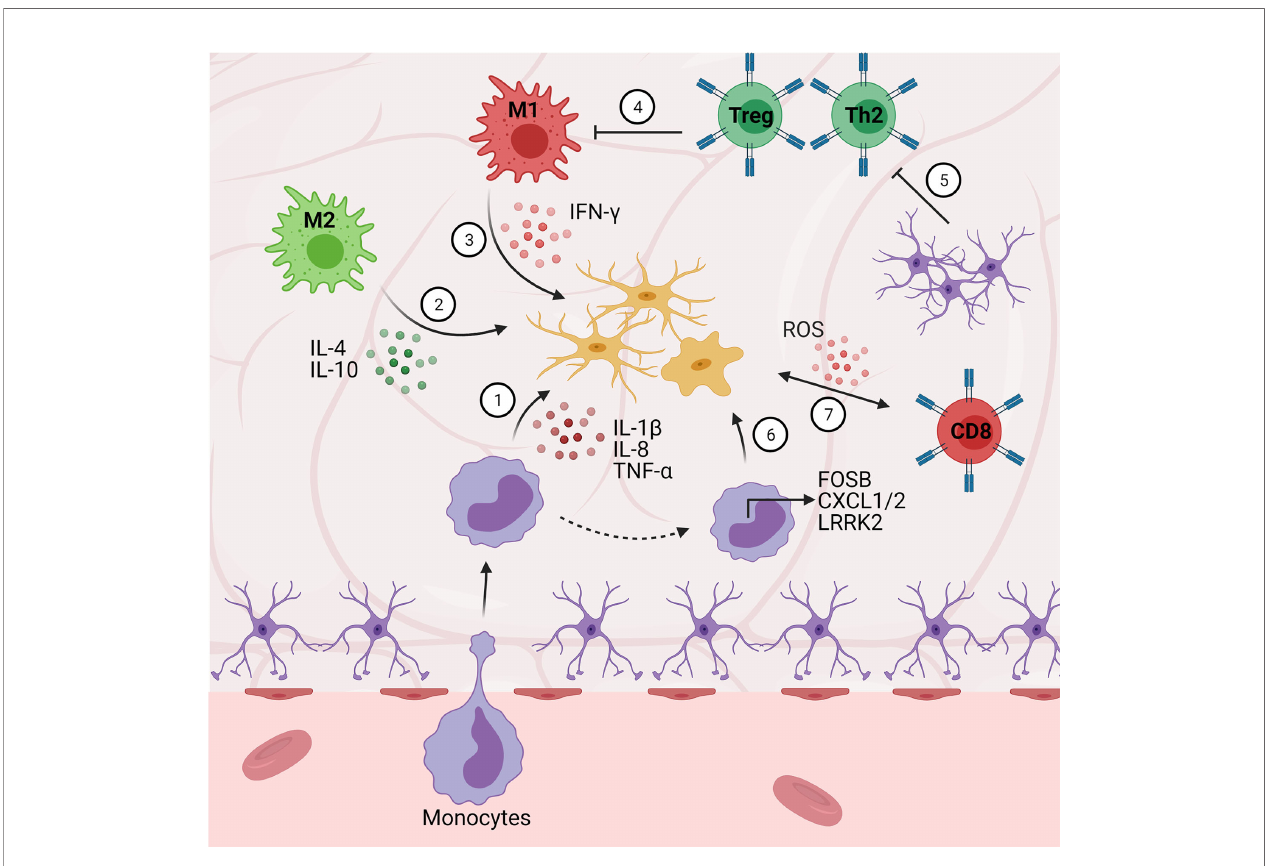
FIGURE 3 | Central-peripheral immune crosstalk in neurodegenerative diseases. (1) In fi ltrating monocytes secrete pro-in fl ammatory factors that activate microglia (e.g., IL-1B, IL-8, FOSB, CXCL1/2). (2) M2 macrophages play an early neuroprotective role via anti-in fl ammatory cytokine (e.g., IL-4, IL-10) secretion. (3) Alternatively, M1 macrophages play a late neurotoxic role via secretion of pro-in fl ammatory cytokines (i.e., IFN- g ). (4) Peripheral Th2 cells downregulate pro-in fl ammatory cytokine secretion (e.g., GM-CSF, TNF- a , IL-2) resulting in decreased microgliosis. (5) Astrocytes secrete TGF- b 1, suppressing neuroprotective T cell responses (ultimately disinhibiting M1 pro-in fl ammatory responses). (6) Monocytes upregulate chemotactic gene expression (e.g., LRRK2), contributing to pro-in fl ammatory pathology. (7) Cytotoxic (CD8+) T cells stimulate microglial ROS